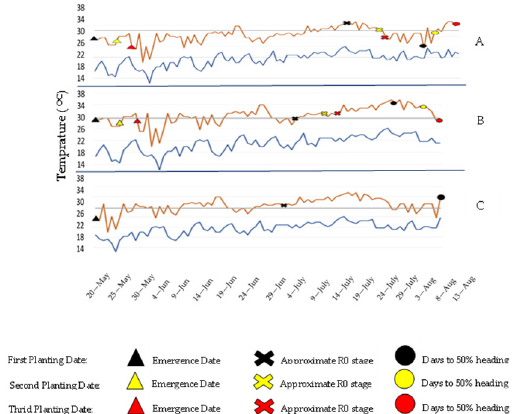
Figure 1. High and low temperatures during TGMS lines 236s ( A ), 811s ( B ), and 801s ( C ) growth in 2017. Temperatures provided by weather stations for Arkansas; black, yellow, and red colors represent first, second, and third planting dates; X, triangle, and circle shapes represent different plant growth stages, including planting dates, R1 stage, and 50% date of heading,